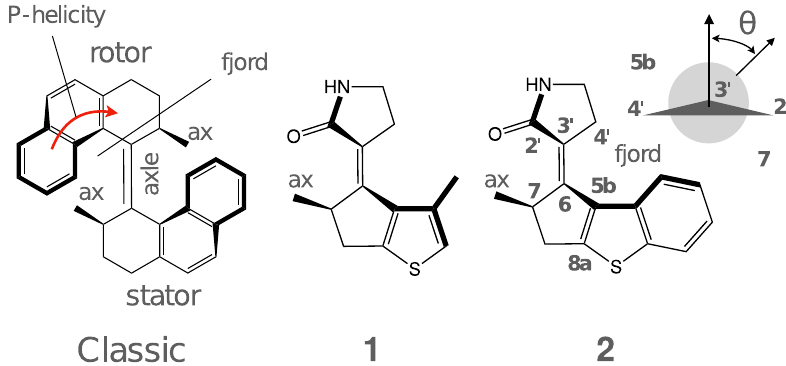
Fig. 1 | Chemical formulae ofthe classic light-driven rotary motor (LDRM) and the LDRMs studied here. The red arrowshows the direction, in which rotation ofthe upper part occurs with respect to the lower part of the motor.